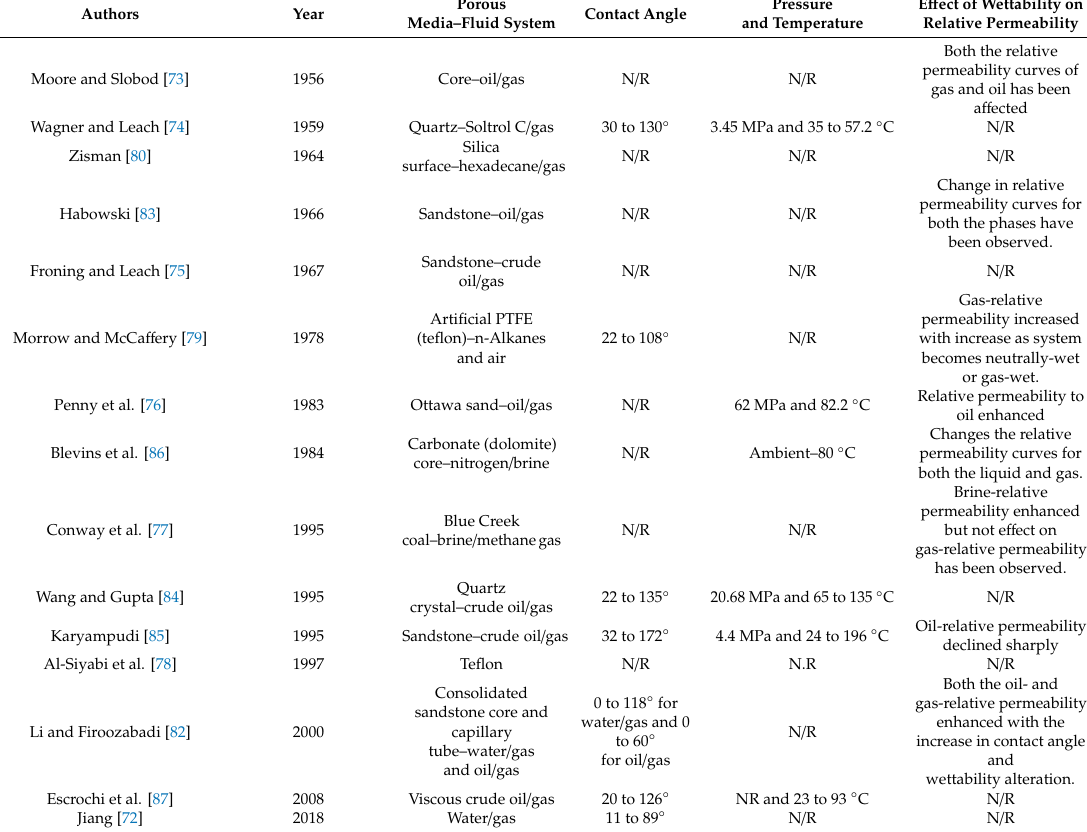
Table 4. Studies on e ff ects of wettability on relative